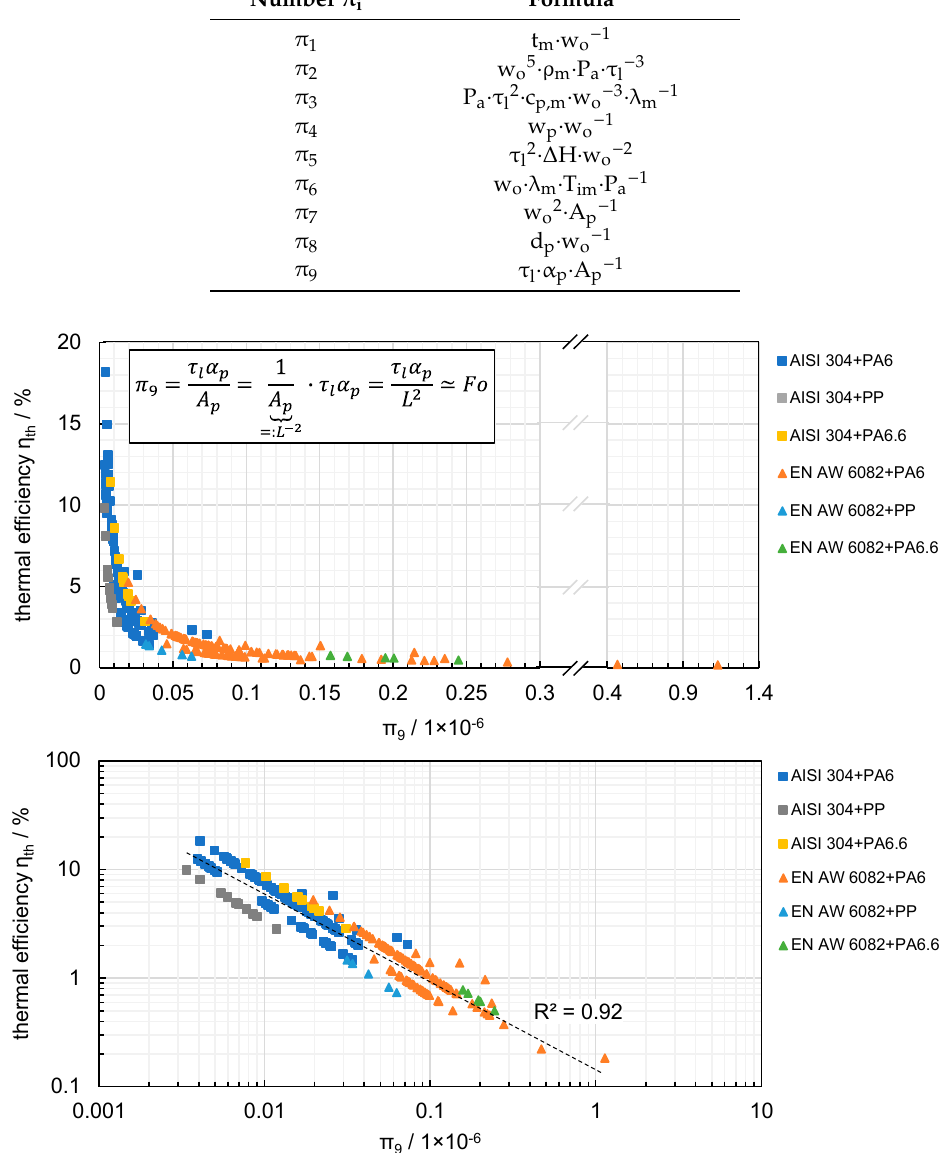
Figure 11. The dependence of thermal efficiency on π 9 in linear ( top ) and logarithmic ( bottom ) representations.